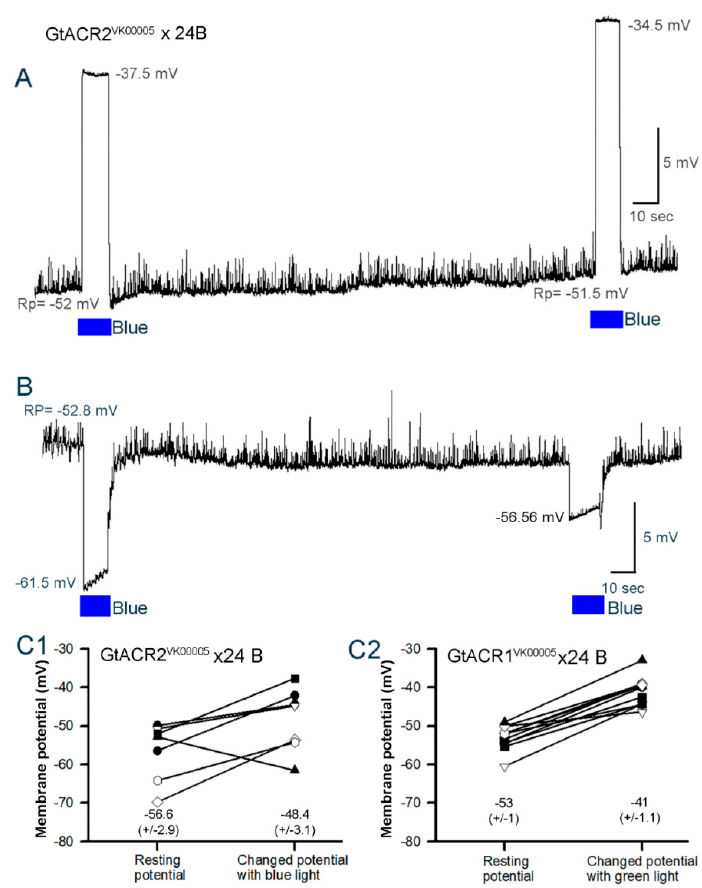
Figure 5. Membrane potential changes in body wall muscle m6 in 3 rd instar larva for GtACR2 VK00005 and GtACR1 VK00005 lines. A representative trace of membrane potential depolarization upon activation with blue light ( A ) and a rare occurrence of hyperpolarization ( B ). The light pulse is 10 s. Note the spontaneous quantal synaptic responses during dark conditioning between pulses and the lack of such occurrences during the light pulses. The change in membrane potentials from resting condition to peak response during the 10 s light pulse for GtACR2 VK00005 ( C1 ) and GtACR1 VK00005 ( C2 ) lines is shown for each preparation. Blue light at 8.8 W / m 2 or green light at 1.5 W / m 2 was used. Mean ( ± SEM) values are presented next to each